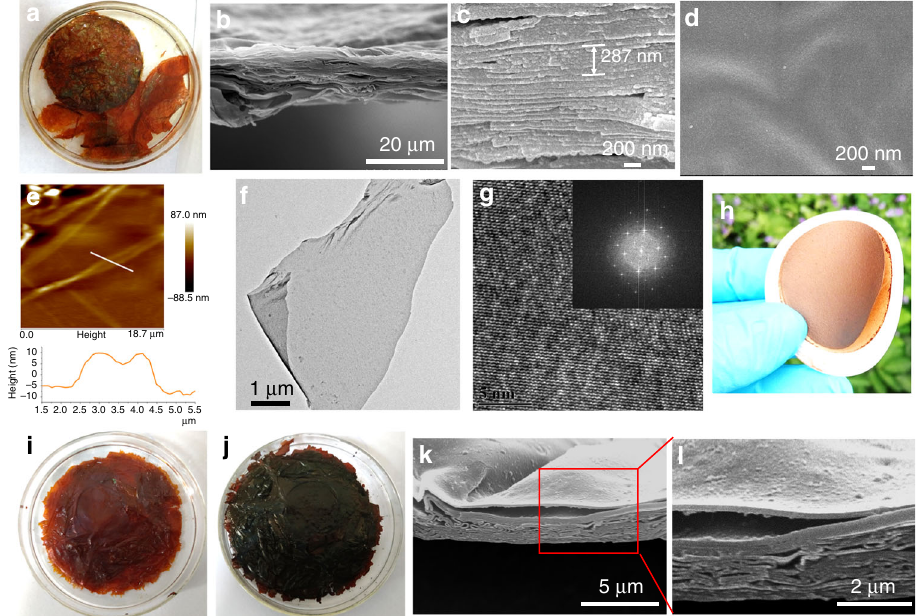
Fig. 2 Morphology characterizations. a Pristine FS-COM-1 collected from the organic – organic solvent interface. b , c Cross-section SEM images of FS-COM-1. d Top-view SEM image of FS-COM-1. e AFM image and the thickness of the nanosheet. f TEM image of the nanosheet with micrometer scale. g High-resolution TEM patterns. h Digital images of substrate-supported membrane (FS-COM-1-VF). i Pristine FS-COM-2 collected from the organic – organic solvent interface (soaked in acetone). j Pristine FS-COM-2 collected from the organic – organic solvent interface (soaked in water). k , l Cross-section SEM images of FS-COM-2. Enlarged view of the inserted red box in k is shown in l